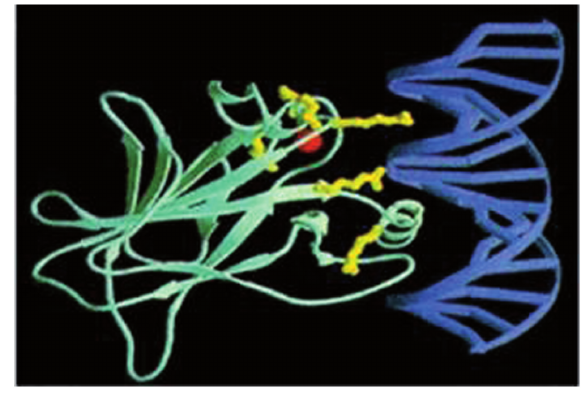
Figure 1 The structure of the core domain of the p53 protein is shown in light blue bound to DNA (dark blue). shown in yellow – all are residues important for p53 binding to DNA. Red ball: zinc atom. Reproduced with permission from Ref.